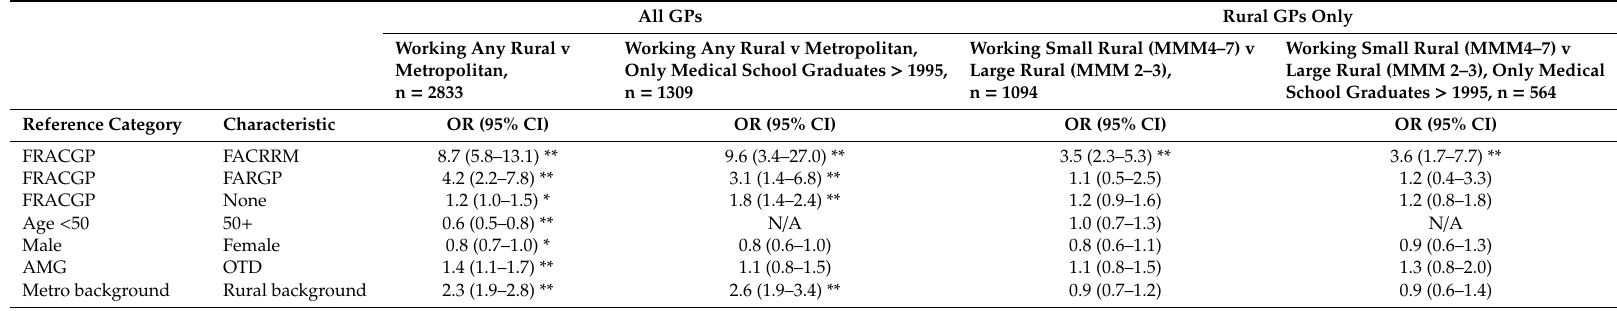
Table 6. Multivariate logistic regression models of geographic distribution by fellowship group and other characteristics (Wave 10—2017,